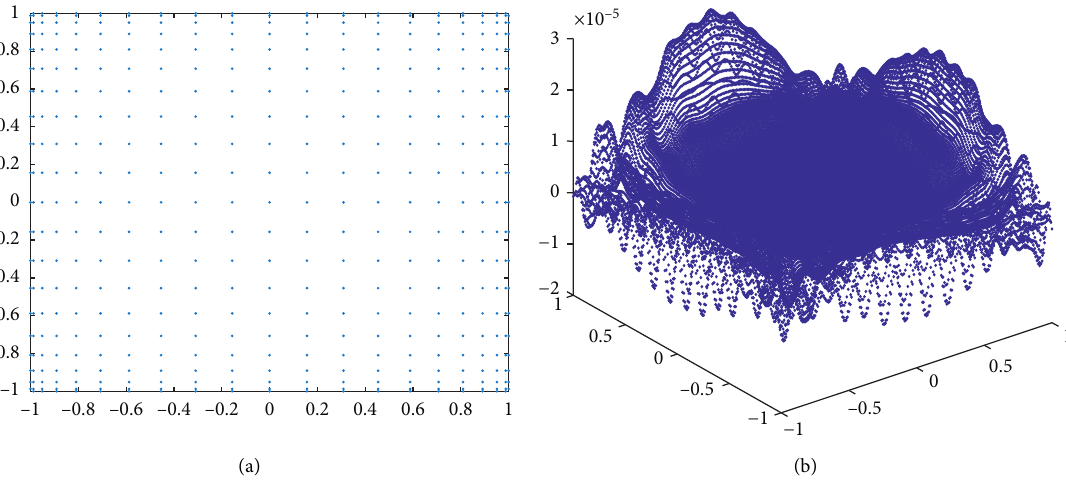
Figure 3: Configuration of the source points (a) and the corresponding absolute errors (b) for the CG-RBF.